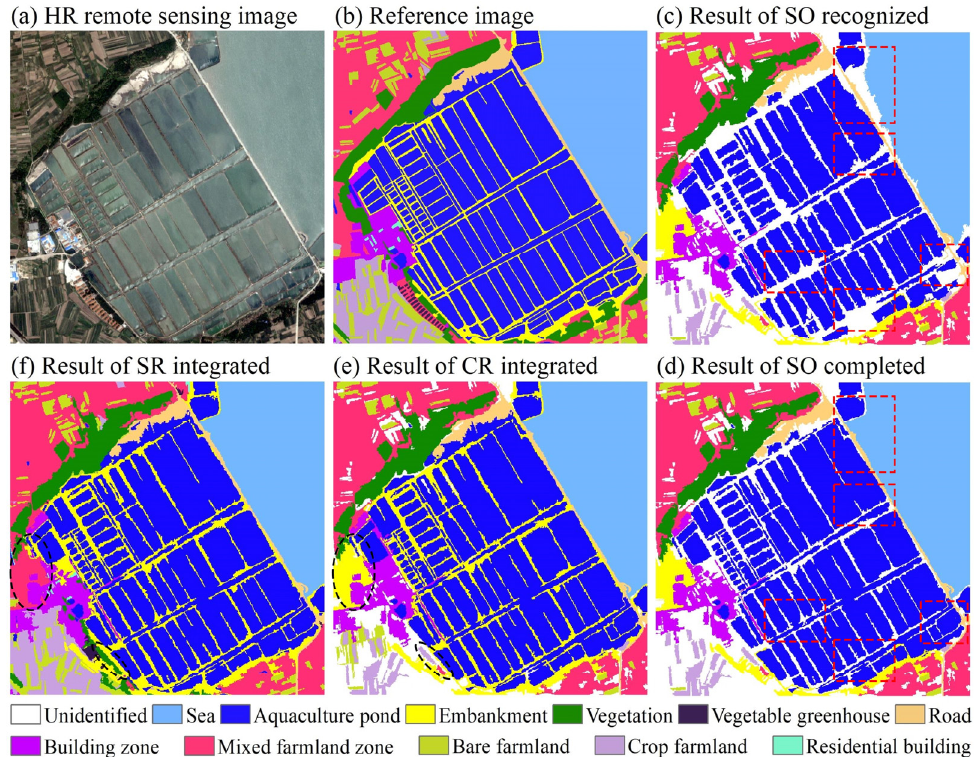
Figure 10. Results of each processing step of scene A. The HR, SO, CR, and SR represent high reso- lution, significant objects, contextual relationships, and spatial relationships, respectively. Different background colors in the imagery represent different land covers. Dashed boxes in different colors represent the significant change areas from the previous result to the next result.